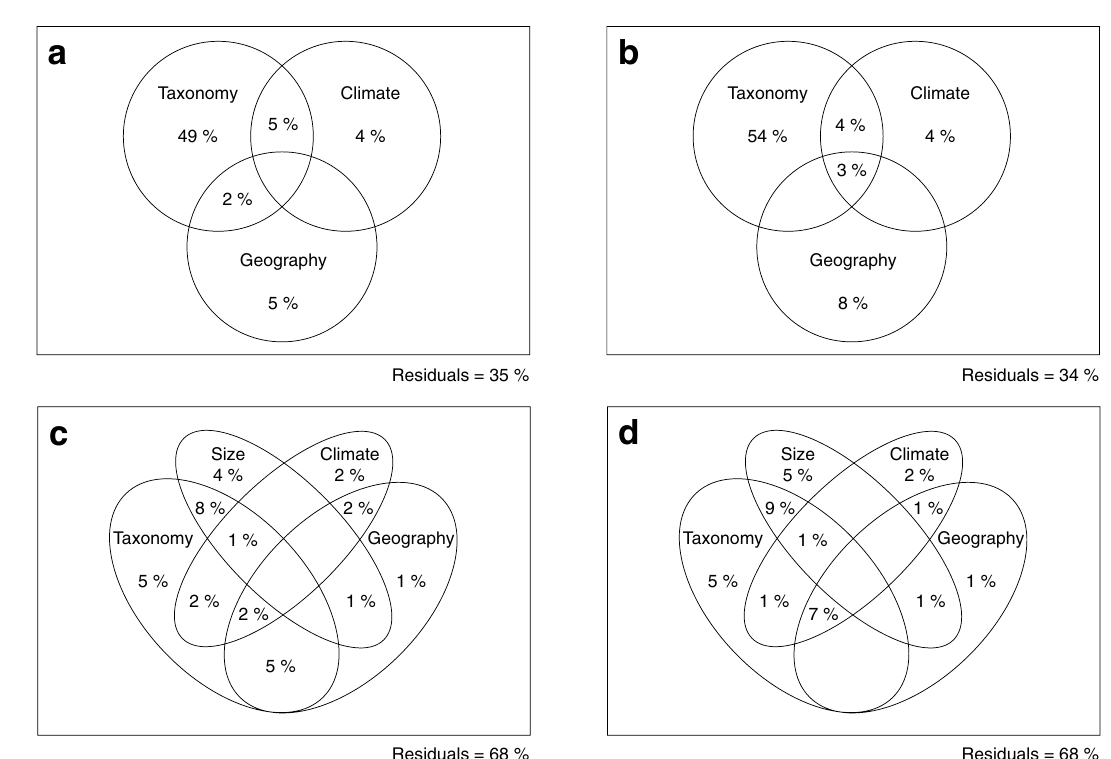
Figure 5. Variation partitioning in size and shape in the C. poensis species complex. Venn diagrams of the variation partitioning analyses for size in ( a ) all specimens, ( b ) adults, and shape in ( c ) all specimens and ( d ) adults. Percentages correspond to the total size and shape variation explained by circled factors (adj.R 2 ). Values < 0 are not